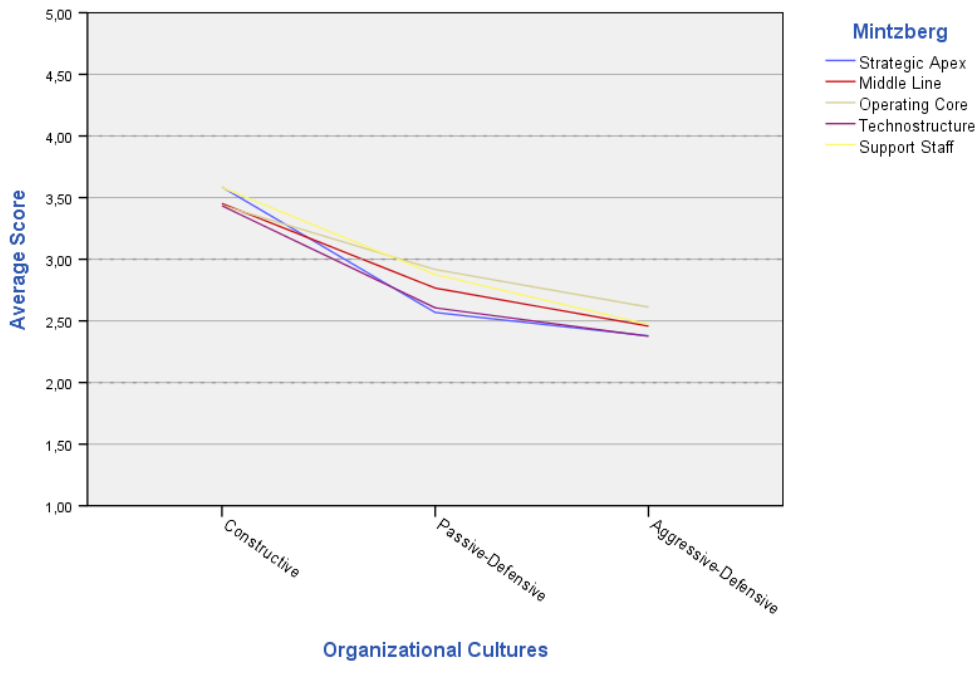
Figure 10. OCI organizational cultures averages by Mintzberg’s organizational components.